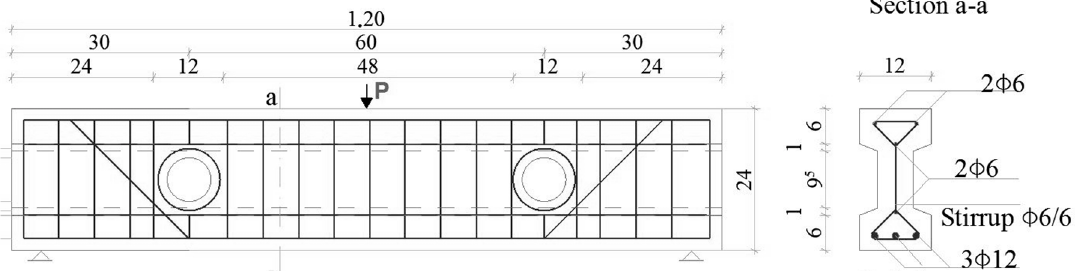
Figure 1. Reinforcement detailing of the beams.